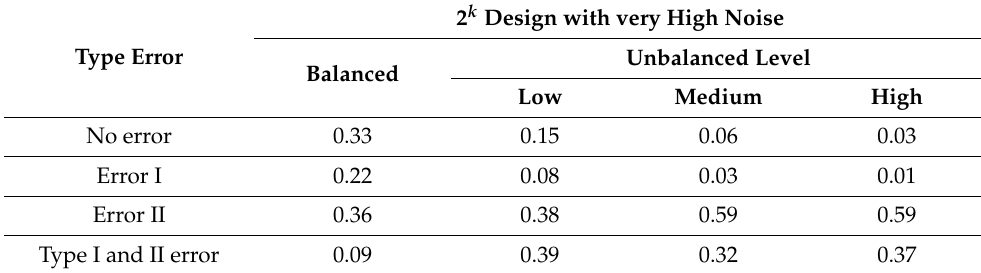
Table 14. Values for different levels of unbalance with very high